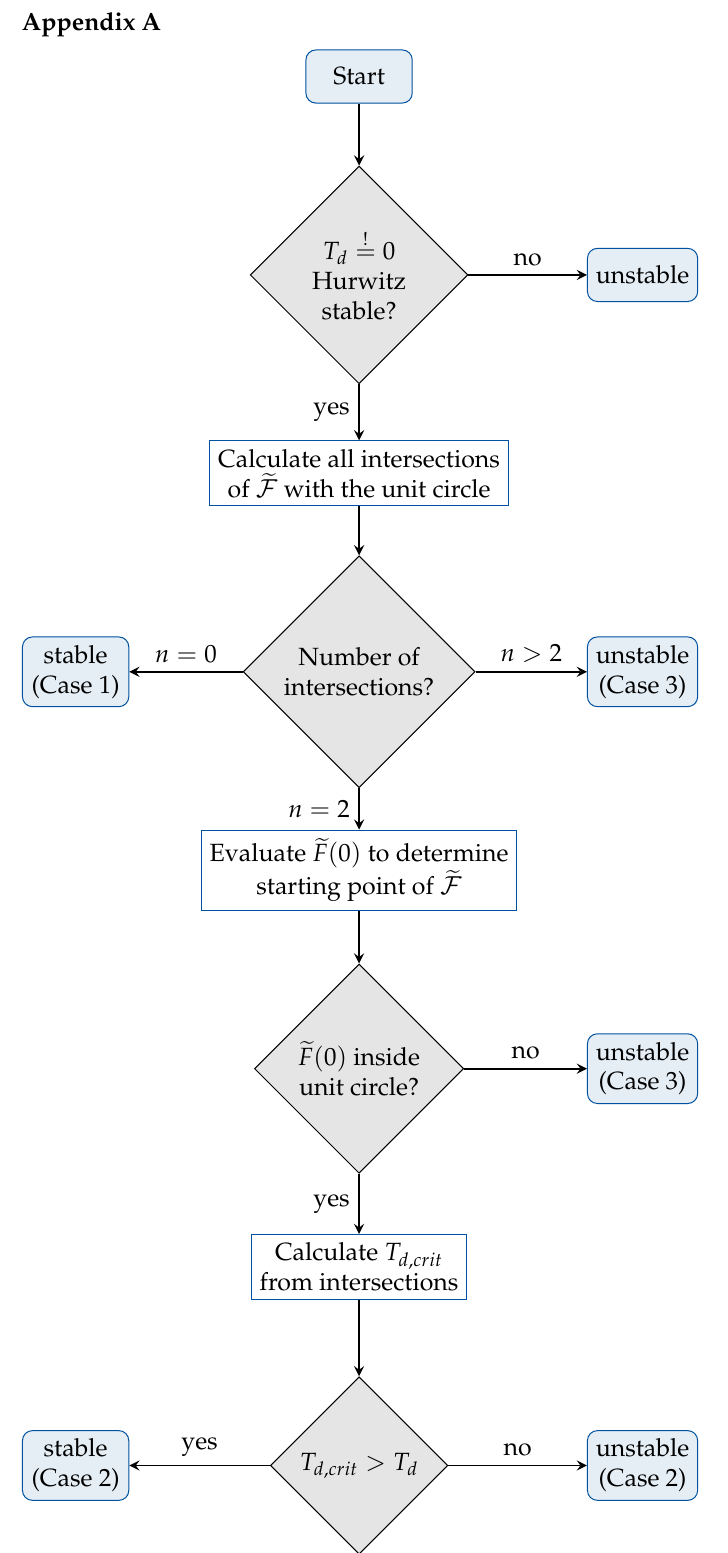
Figure A1. Flow diagram for visualizing all case distinctions during the evaluation of the sufficient stability criterion described in Section